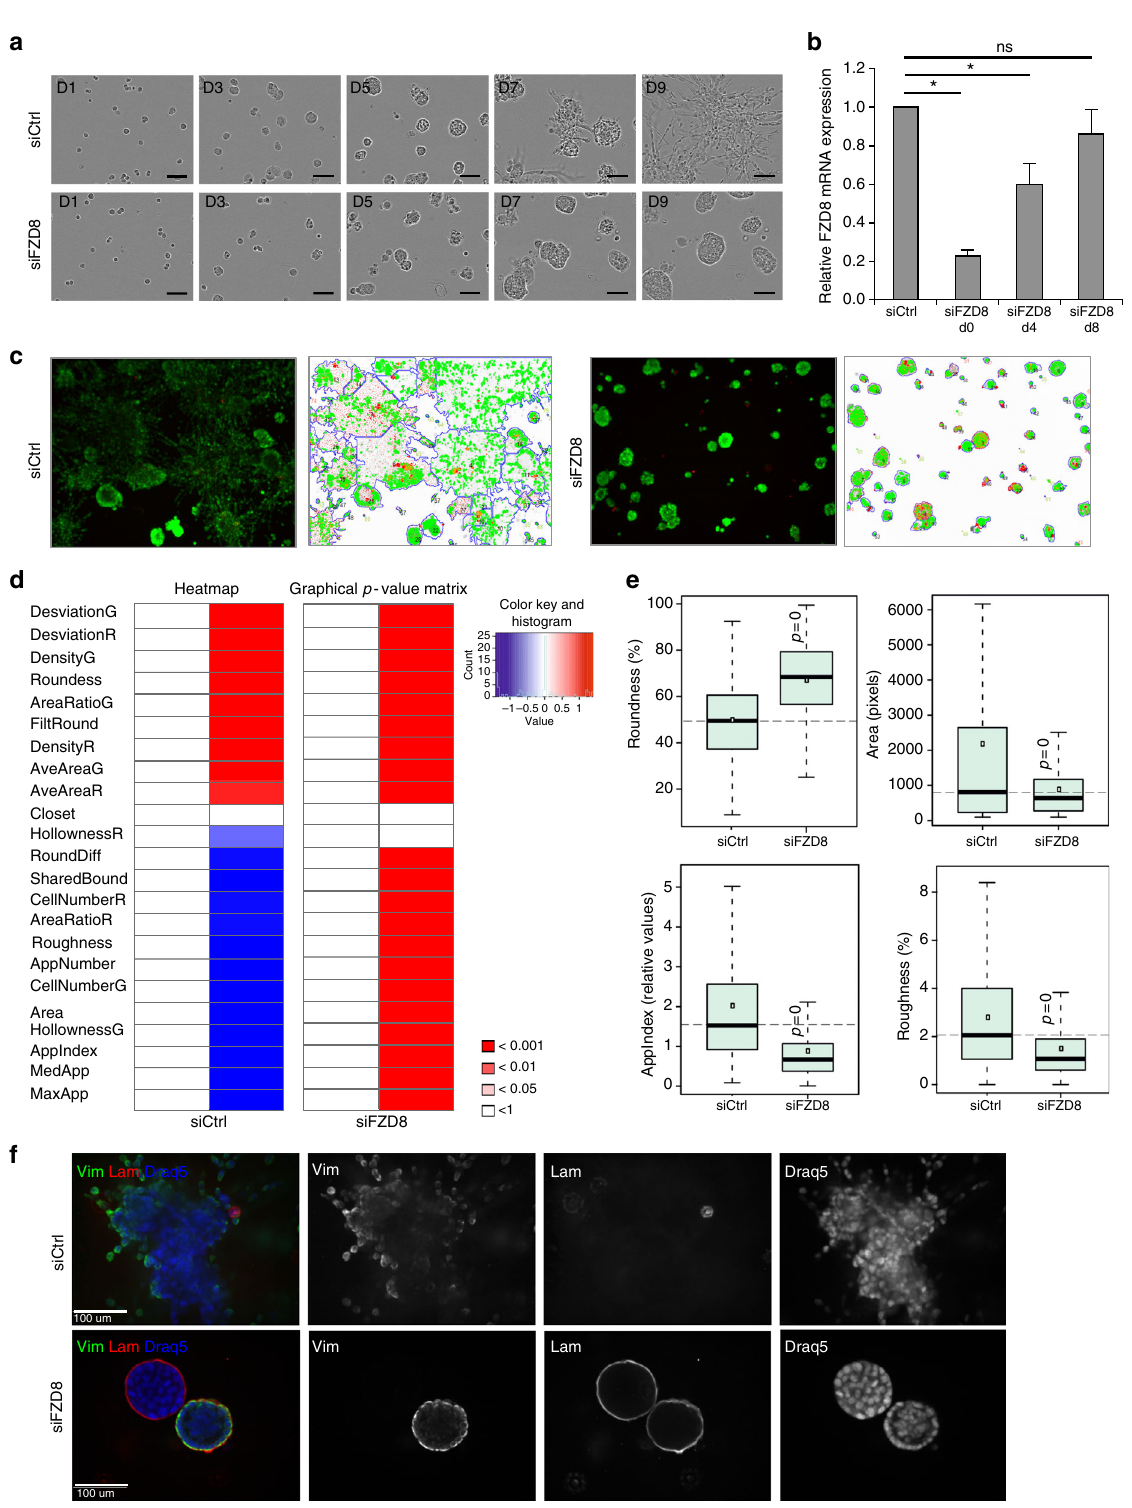
Fig. 3 FZD8 is required for prostate cancer cell invasion in organotypic 3D cultures. a Representative images from live-cell imaging of 3D cultures of control (siCtrl) and FZD8-silenced PC-3M cells at days 1 – 9; scale bar 100 μ m. b FZD8 expression levels in siRNA-transfected cells at days 0, 4, and 8 of 3D culture. Error bars indicate SD from three independent experiments (* p < 0.05, ** p < 0.001 by ANOVA with Tukey post hoc test, ns indicate non- signi fi cant). c Representative segmentation of live-cell spinning disk confocal images of FZD8-silenced PC-3M cell organoids cultured in 3D for 9 days. Organoids were segmented and analyzed by AMIDA; apoptotic cells are in red (ethidium homodimer-1) and live cells in green (calcein). d Heatmaps and graphical p -value matrix of morphometric parameters measured by AMIDA and found to be altered by FZD8 silencing (red: increased, and blue: decreased). p- values displayed in the fi gure are Bonferroni-corrected from t -tests, comparing siFZD8 and siCtrl. e Box and whisker plots of selected parameters from heatmaps; p = 0 indicates p < 0.001. For explanation of the morphometric parameters, see Supplementary Table 4. f Confocal microscopy analysis of organoids derived from siCtrl and FZD8-silenced PC-3M cells at day 9 of growth in 3D culture; immunostaining for vimentin (Vim) is shown in green and for laminin- α 1 (Lam) in red, blue staining shows cell nuclei (Draq5), scale bar 100 µ